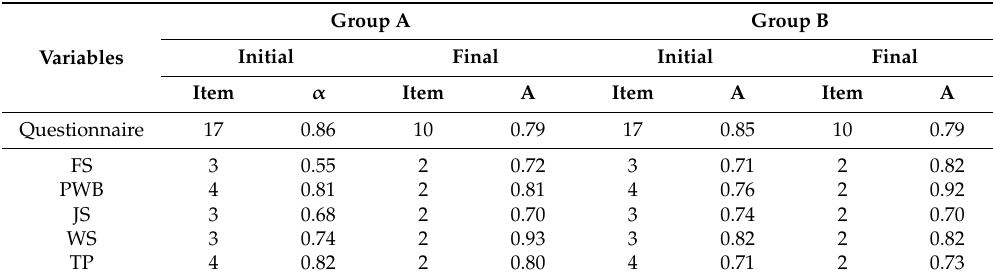
Table 5. Validity and reliability tests of both worker groups.